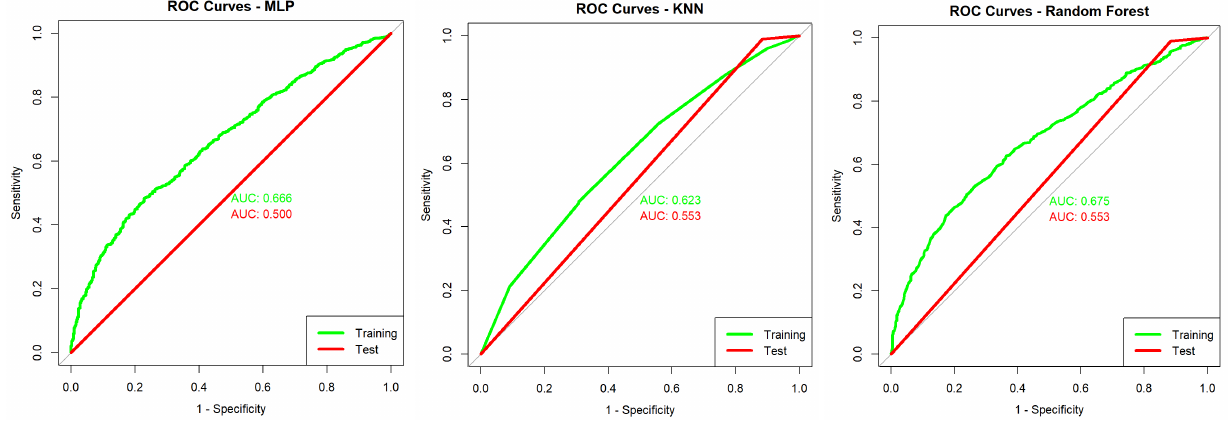
Figure 13. ROC curves for MLP , kNN and Random Forest models.